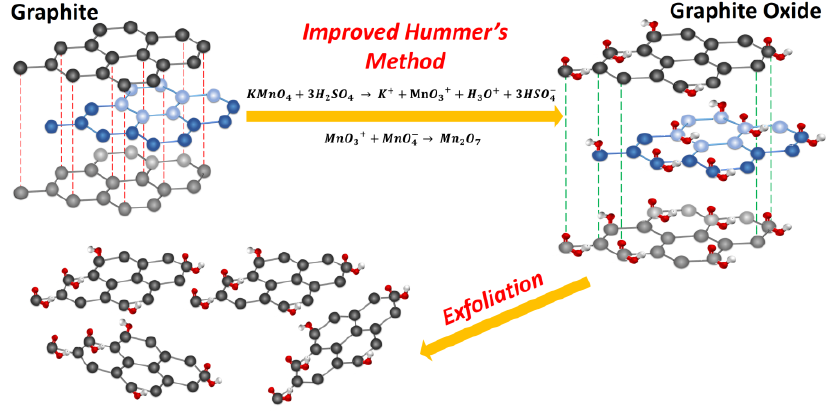
Figure 1. Scheme of the preparation of graphene oxide from graphite.